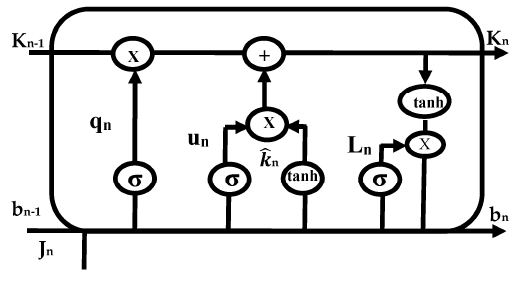
Figure 2. LSTM cell.